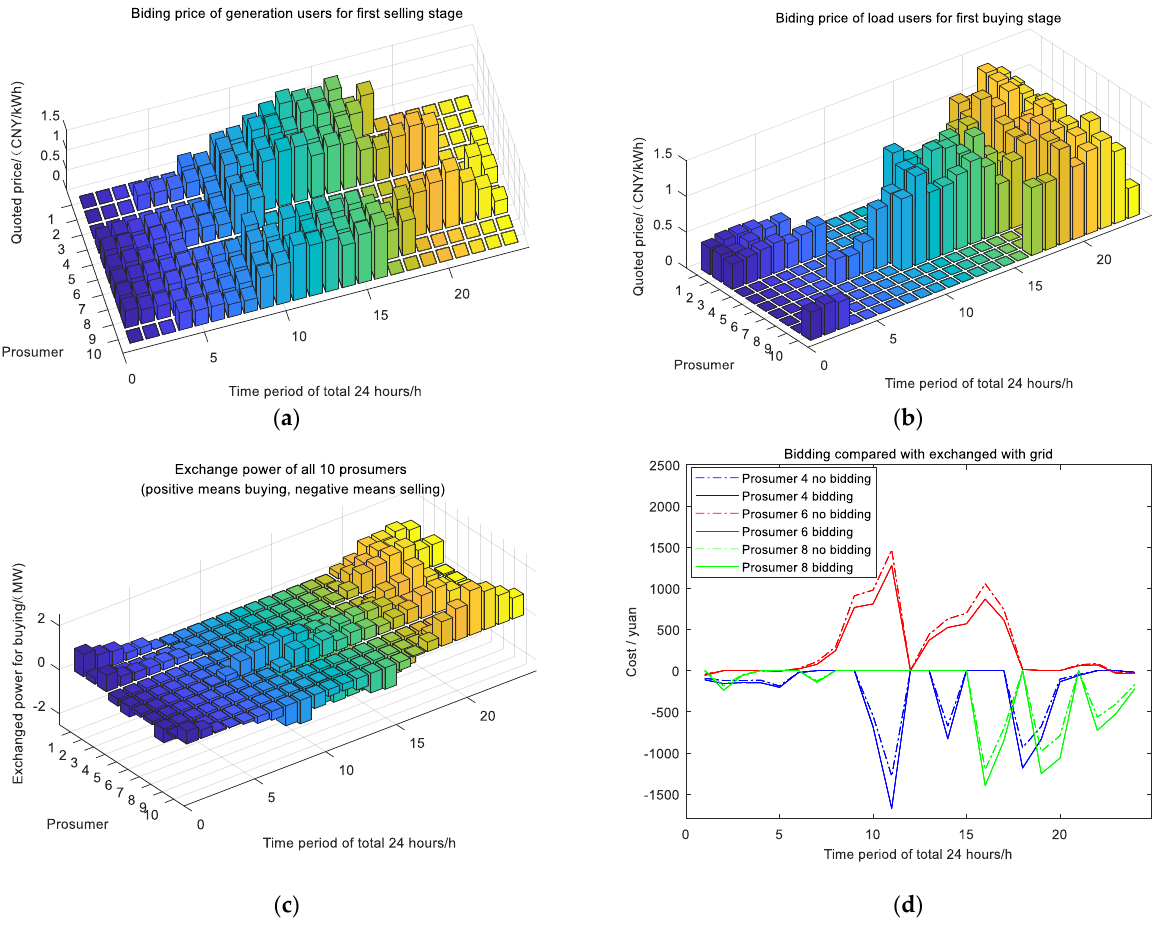
Figure 16. The bidding scenario for the first stage of P2P distributed trading. ( a ) Generation users; ( b ) Load users; ( c ) Exchanged power after first matching; ( d ) Bidding costs compared with exchanged with grid about prosumer 4, 6 and 8. Table 6. The cost comparison of the successfully traded exchange power for 24 h under two scenarios.